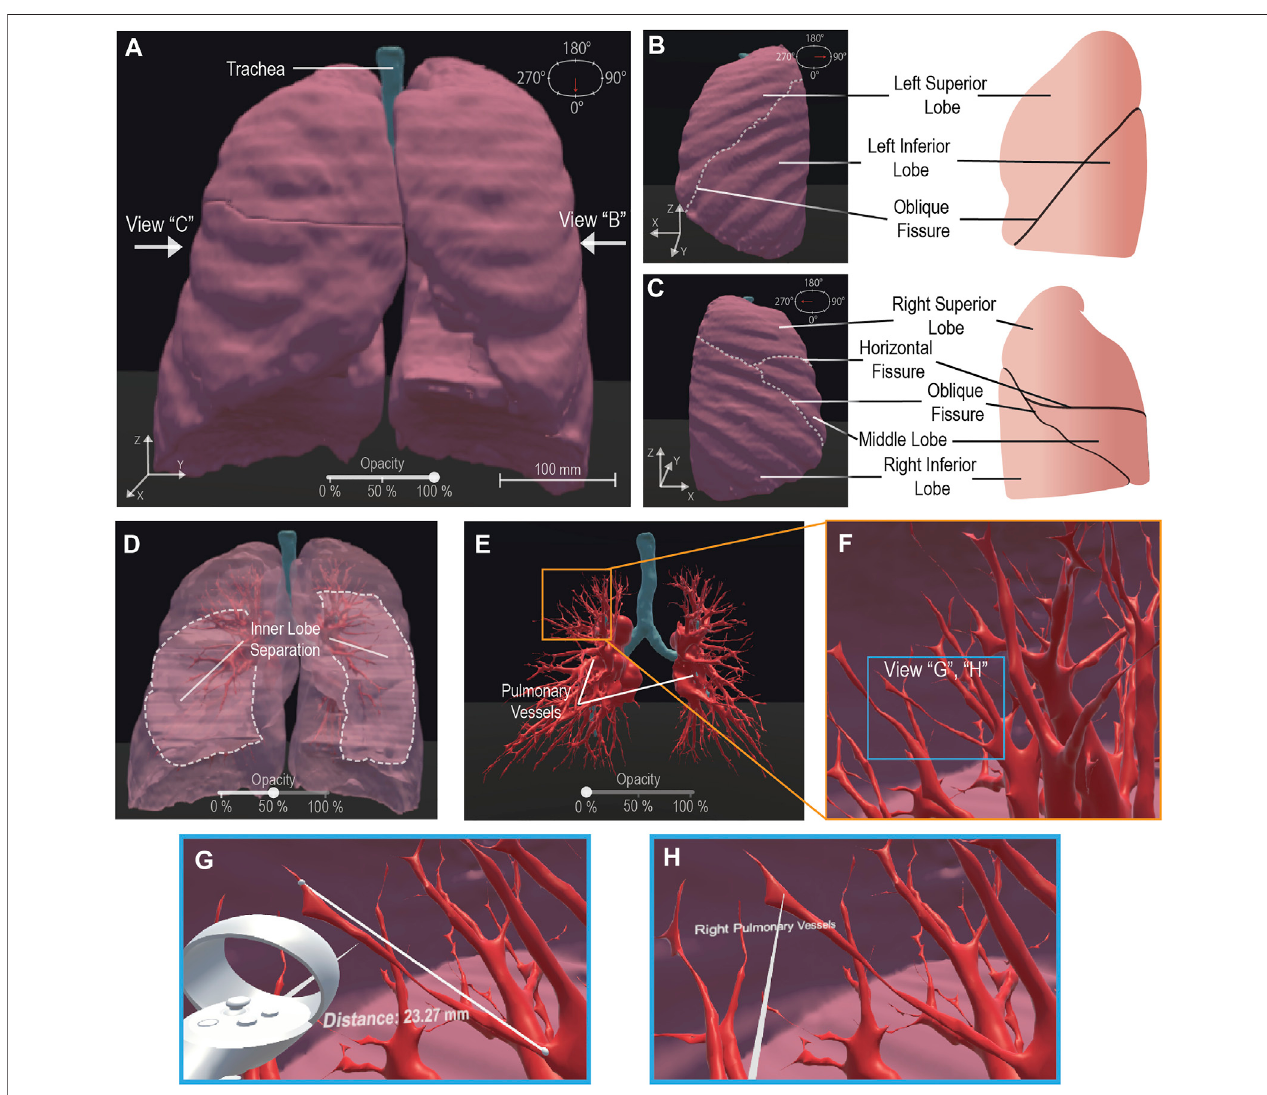
FIGURE 2 | VR Basic Operations on 3-D CT Lung Model. We demonstrate the maneuverability within VR to explore the 3-D model moving from an initially centralized view (A) to a 90 ° rotated view (B) and a 270 ° perspective (C) , the scale is noted at 100 mm (A) . The 100% opacity model (A – C) is returned to a centralized viewwhereinwedemonstratetheadjustableopacityfunctionality (D,E) .Weadjusttheopacityto50% (D) visiblydisplayingtheinnerdistinctionbetweenlobeswithinthe lung, then further adjust the opacity to 0% (E) to display the visibility of the pulmonary vessels for analysis. We represent VR immersion by going into the lung and viewing the 3-D pulmonary vessels (F) . Inside VR to enhance model analysis, it is demonstrated that a measurement functionality (G) is present, for quantitative information, displaying “ Distance: 23.27 mm ” and a labeling functionality (H) , for qualitative description, details a speci fi c model section as the “ Right Pulmonary Vessels ” . Scale bar: 100